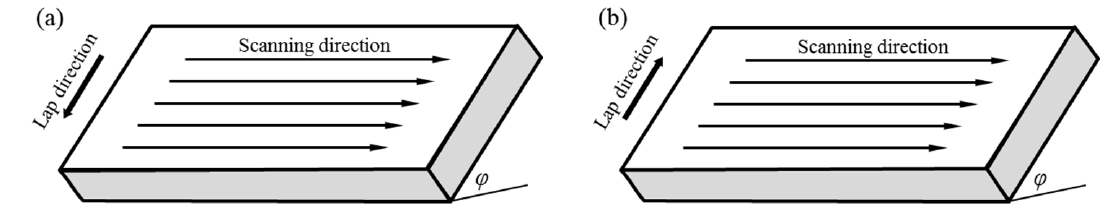
Figure 3. Lap directions: ( a ) downward; ( b ) upward.